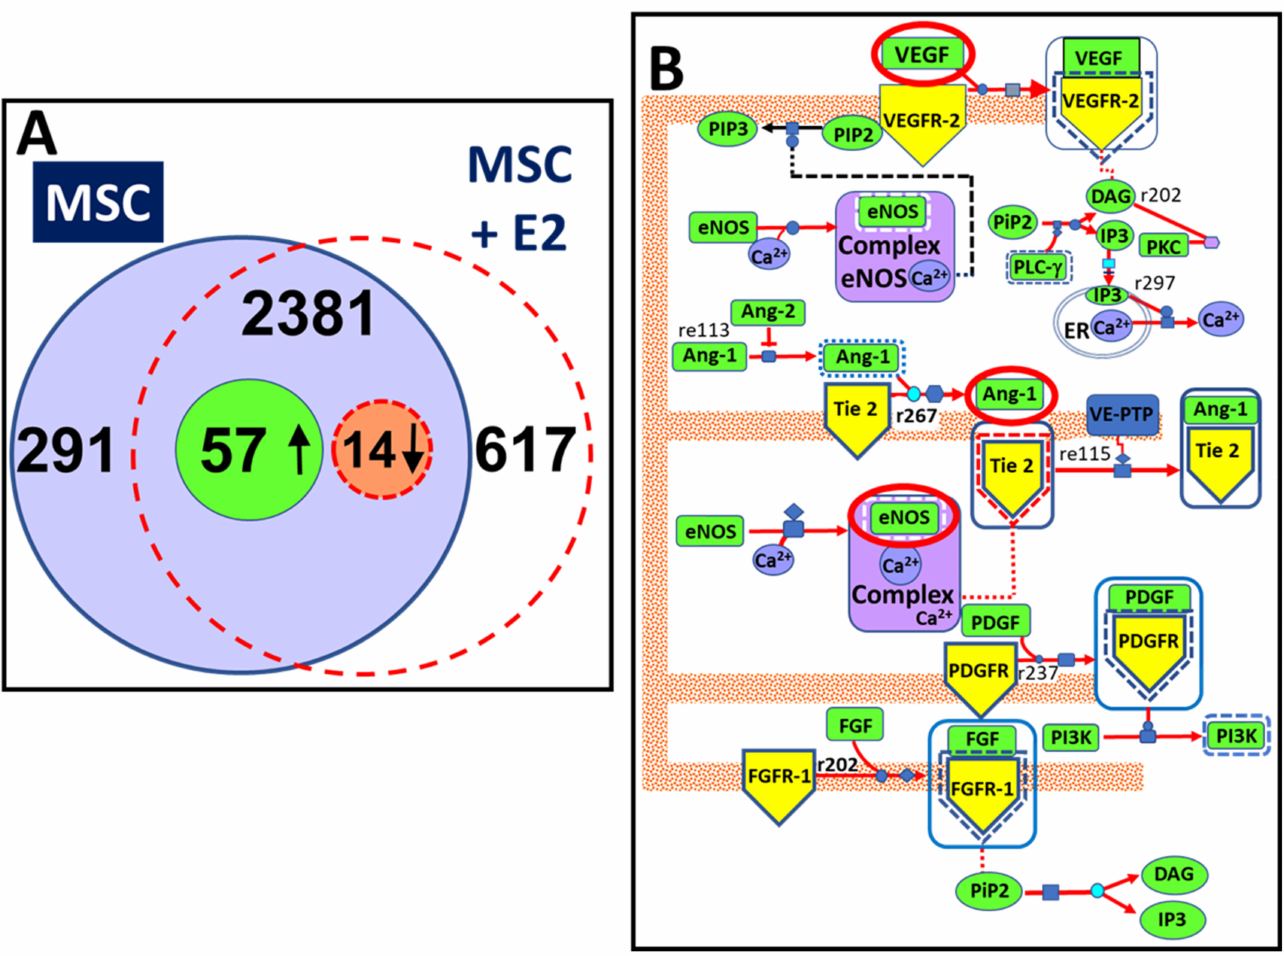
Figure 2. Liquid chromatography-mass spectrometry (LC-MS) testing revealed that E2 up-regulated proteins involved in angiogenesis and tissue remodeling. ( A ) represents the entire proteomic profile data of the in vivo Matrigel ® plugs for each group (sham-operated and OVX) after LC-MS and bioinformatic analysis. A total of 2381 proteins were collectively identified in both control implants and Matrigel ® plugs containing MSCs treated with E2. The relative quantitative analysis revealed 57 up-regulated and 14 down-regulated proteins ( p -value < 0.05). ( B ) illustrates statistical analysis (using Panther) of the protein pathways modulated by E2 presence in MSCs. Analyzing the proteins from excised Matrigel ® plugs (containing E2 treated MSCs), we discovered proteins mainly involved in angiogenesis processes. VEGF (vascular endothelial growth factor), Ang-1 (angiopoietin 1), Tie-2 (angiopoietin receptor 2), and eNOS (endothelial nitric oxide